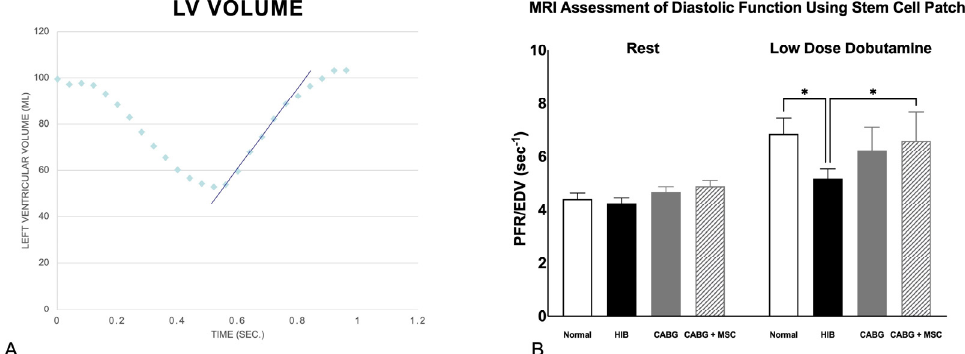
Figure 1. ( A ) Diastolic relaxation. Relationship of left ventricular volume throughout the cardiac cycle. X-axis: time in seconds; Y-axis: left ventricular volume in milliliters. The blue slope line represents the peak diastolic filling rate, noted as the fastest rate at which the left ventricle increases in volume. The highest positive slope, usually occurring just after the end-systole, represents the peak filling rate (PFR), which is normalized to the animal’s end-diastolic volume (PFR/EDV) to account for size variance across animals. ( B ) Measurements of Peak Filling Rates using cardiac MRI. Diastolic function, as measured by PFR/EDV, was compared among four groups (Control, HIB, CABG, and CABG + MSC). At rest, the PFR/EDV measurements are similar among the control (N = 6), Hibernating myocardium (HIB) (N = 17), CABG (N = 19), and CABG + MSC (N = 9) animal groups. However, significant differences exist during low–dose dobutamine infusion. Under stress, HIB animals show a significant decrease in PFR/EDV when compared to the control (* p < 0.05), with some improvement in the CABG-only group ( p = 0.06) and a significant increase in the CABG + MSC group (* p < 0.05). A one-way analysis of variance (ANOVA) test was used for statistical analyses. Data are presented as the means ± SD. CABG = Coronary artery bypass graft, MRI = Magnetic resonance imaging, MSC = Mesenchymal Stem